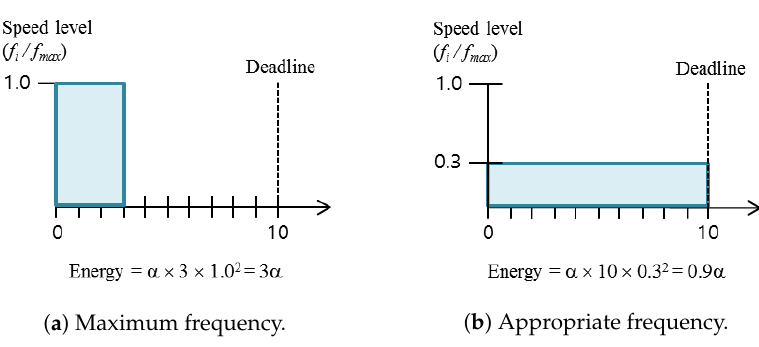
Figure 2. Dynamic voltage scaling (DVS) for real-time